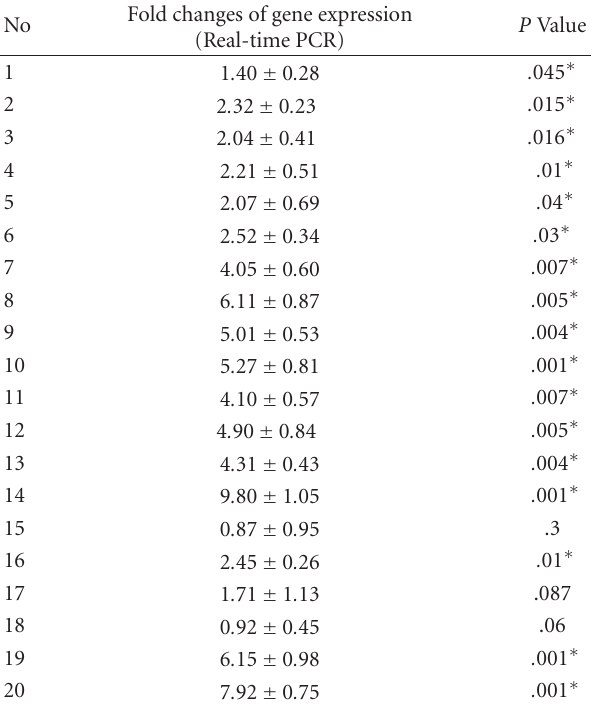
Table 3: Lcn2 expression fold changes in SM-exposed patients in comparison with control group ( ∗ Statistical significance: P < . 05).